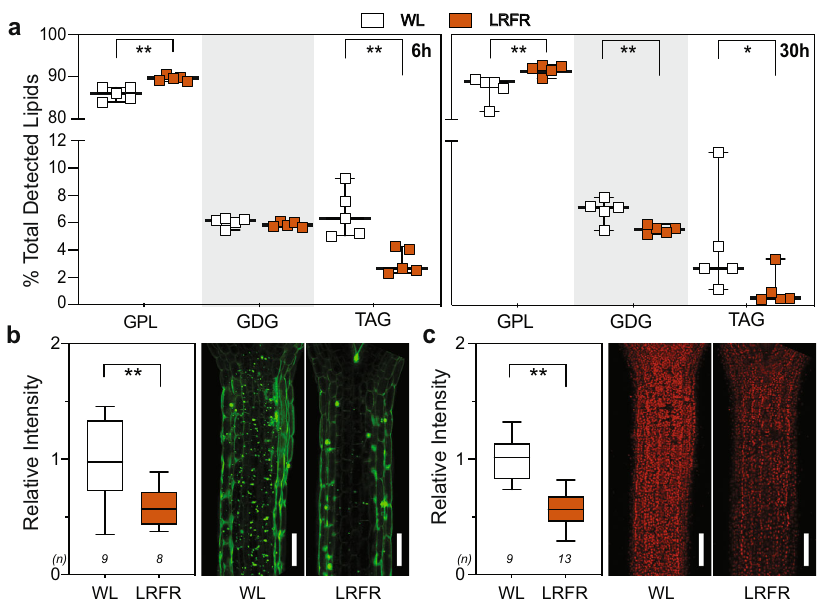
Fig. 6 | LRFR changes the lipid composition in hypocotyls. a Lipid class abun- danceattheindicatedtimepointsisrepresentedaspercentageoftotaldetected lipids in B. rapa hypocotyls. Each data point indicates biologically independent samples,horizontalbarrepresentsthemedian,whiskersextendtoshowthedata range. GPL glycerophospholipids, GDG glycosyldiacylglycerols, TAG triacylgly- cerols. b , c Quanti fi cation (left) and representative images (right) of ( b ) LDs using BODIPY ™ 493/503 and ( c ) chloroplasts in Col-0 hypocotyls either kept at WLortransferredtoLRFRfor30h.DataisnormalizedtoWLaverage.Whitebars